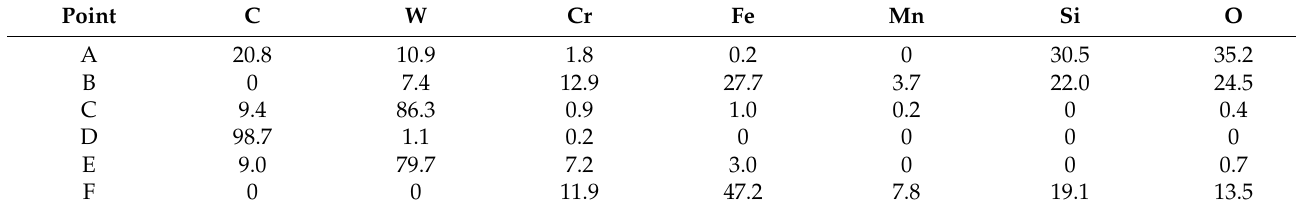
Table 2. Chemical composition at typical position of wear scar (wt. %).